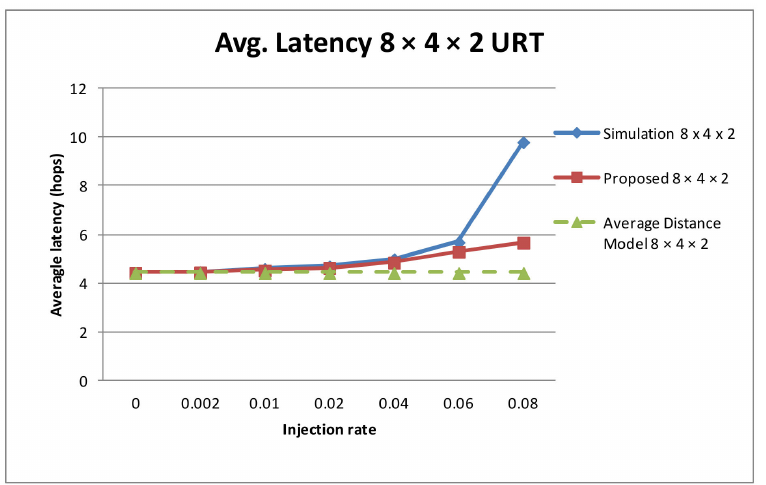
Figure 6. Average estimated latency vs. flit injection rate comparison between simulation, the proposed model and the average distance model for a 8 × 4 × 2 NoC topology and uniform random